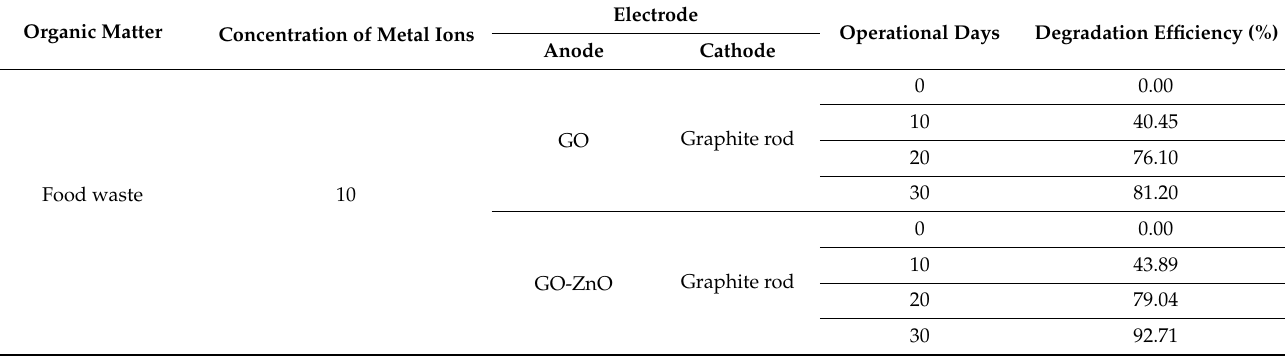
Table 4. Overview of the degradation of metal ions with the GO and GO-ZnO via MFCs.